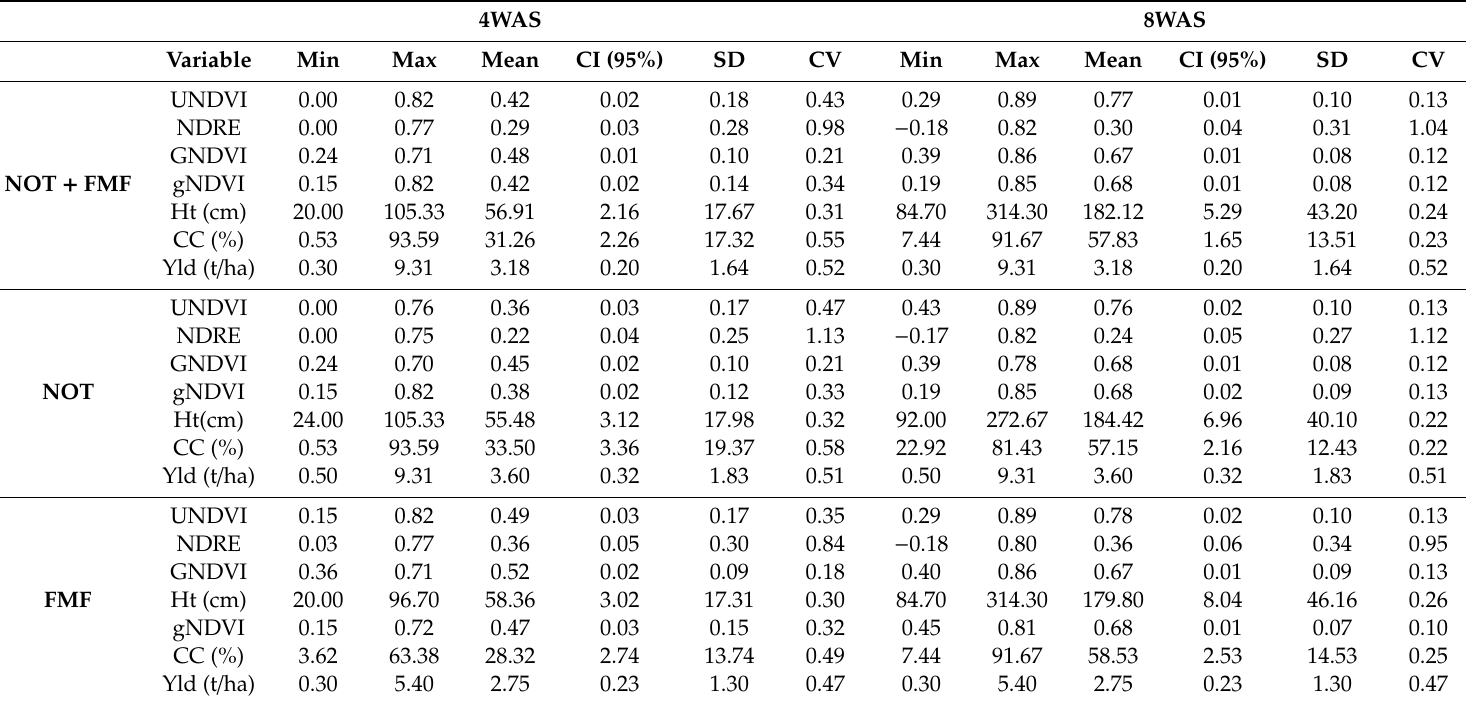
Table 2. Descriptive statistics of measured biophysical variables and UAV-derived vegetation indices within multilocation smallholder maize-farms at two growth